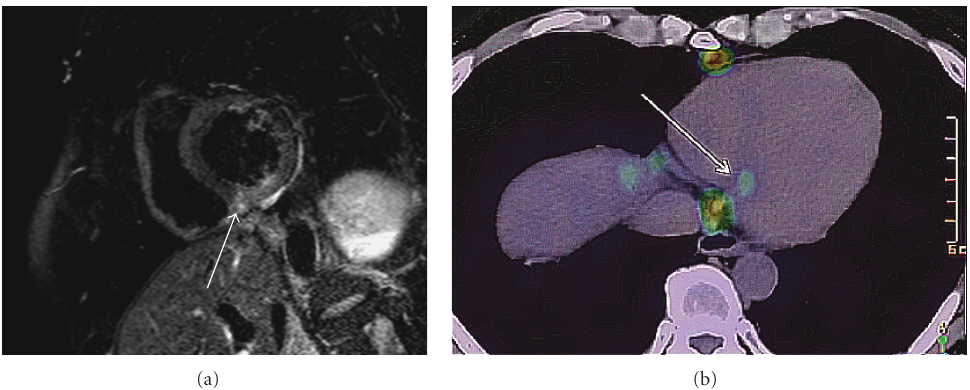
Figure 6: 41-year-old male with cardiac sarcoidosis presenting with premature ventricular contraction. Short-axis T2-weighted MRI (a) shows a small myocardial edema at the inferior septal myocardium (arrow). 18 FDG-PET (b) shows the focal inflammation (arrow), consistent with the edema on MRI.